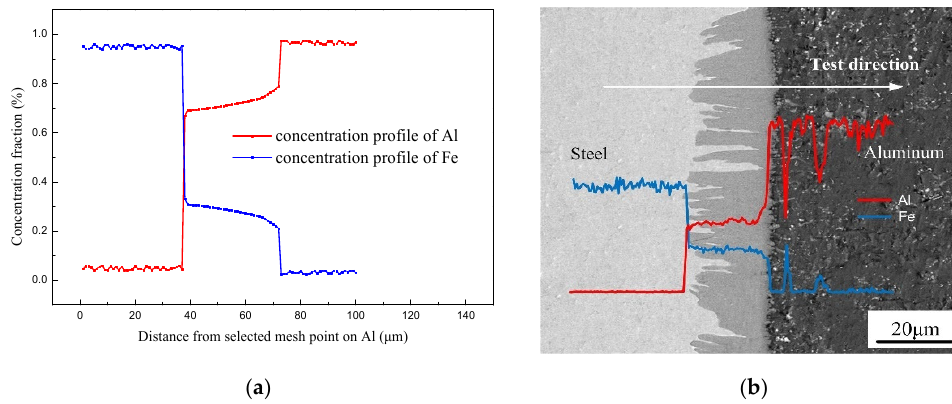
Figure 12. Concentration profiles of Fe and Al across interface: ( a ) solute distribution of simulated result and ( b ) EDS line scanning across the interface.